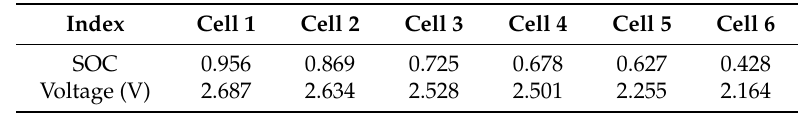
Table 1. Initial state of